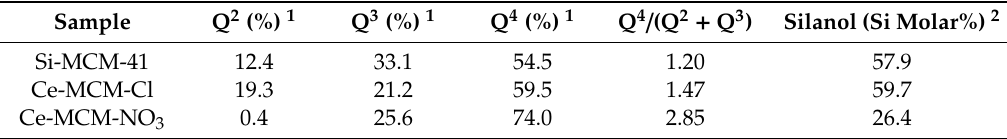
Table 3. Content of Q n -groups and related parameters obtained from 29 Si MAS-NMR spectra of the calcined MCM-41 materials.